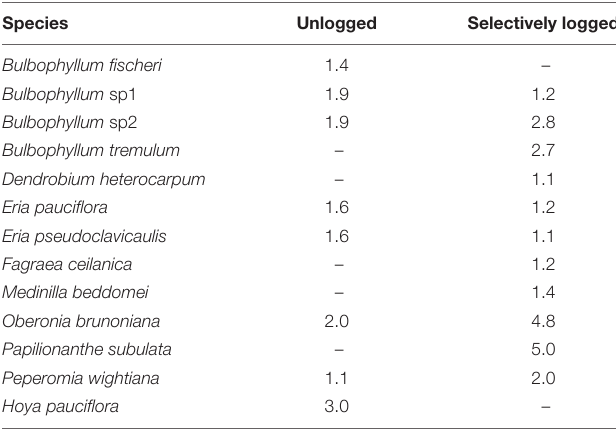
TABLE 2 | Niche width of vascular epiphytes computed using the Levin’s Index are presented for unlogged and selectively logged